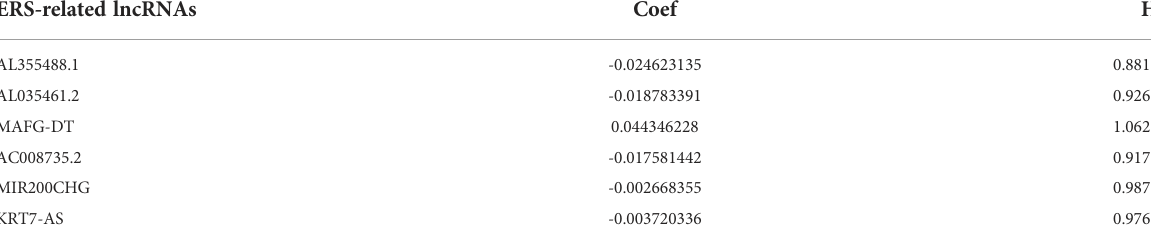
TABLE 1 The prognostic signi fi cance of the 6-lncRNAs signature.